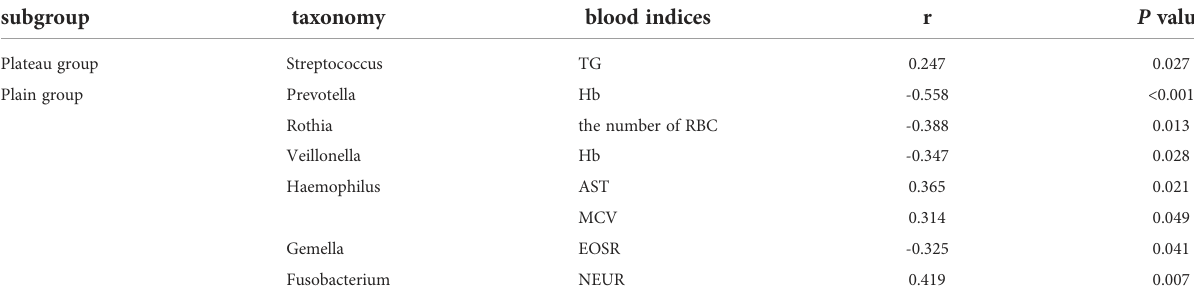
TABLE 3 Correlation between bacteria abundance and blood indices in different groups. subgroup